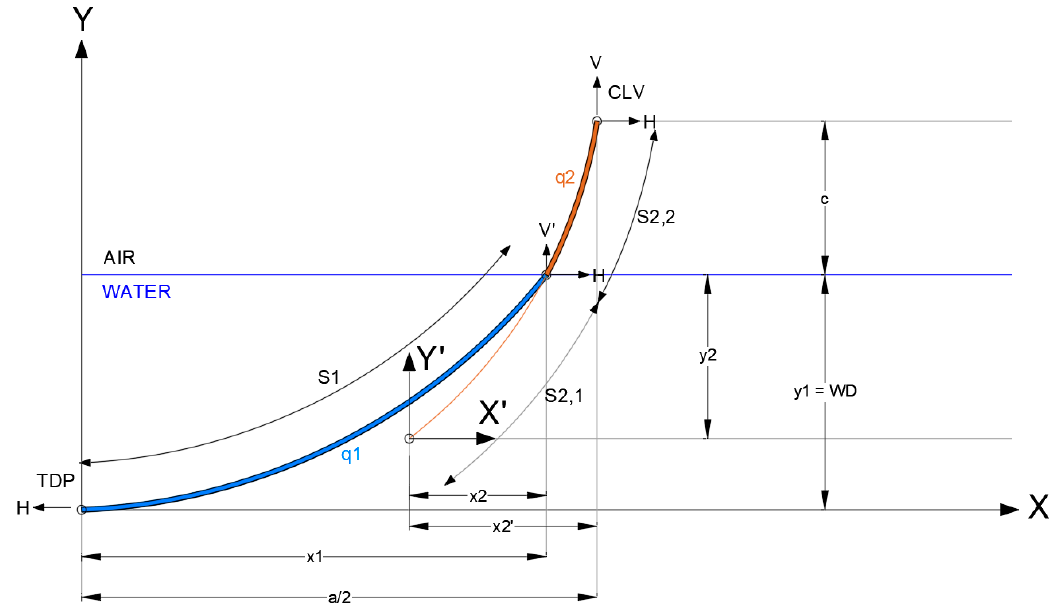
Figure 2. Symbols used for mathematical formulation.